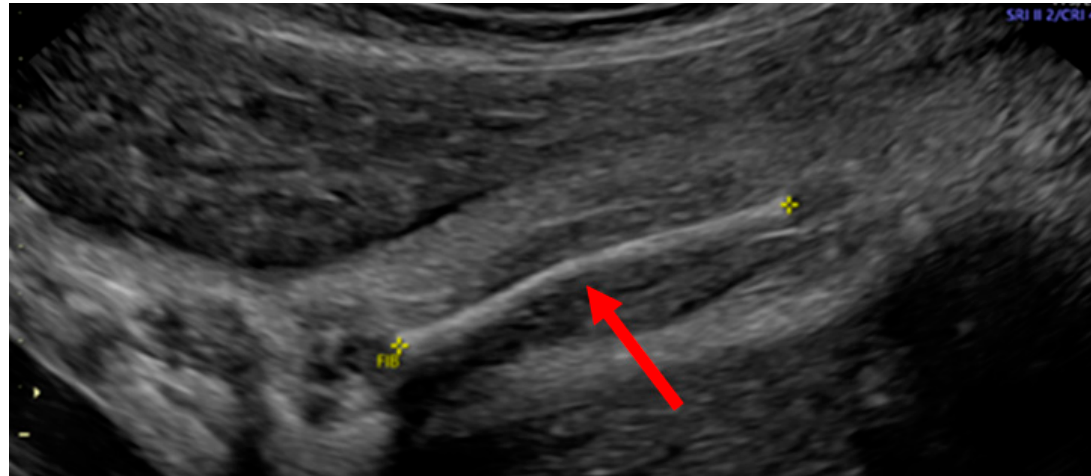
Figure 2. There was mild anterior bowing of the left fibula and, to a lesser extent, tibia. Holick MF, copyright 2021.